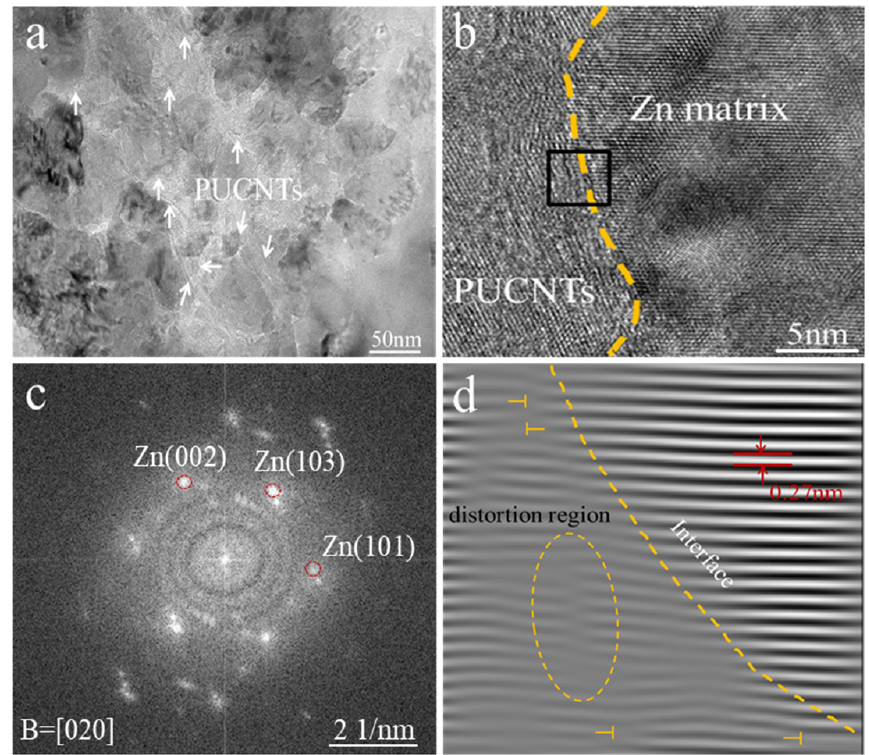
Figure 4. ( a ) TEM image of the PUCNTs/Zn composites. ( b ) The interfacial relationship diagram of Zn and PUCNTs. ( c , d ) The FFT and IFFT images of the black selected area in ( b ), respectively.